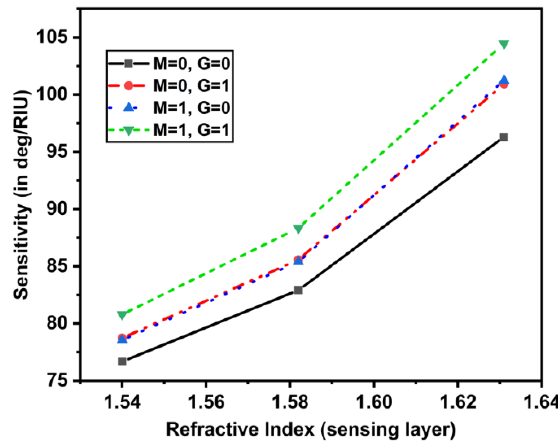
Figure 5. Sensitivity plot w.r.t. the RI of sensing layer (1.54 to 1.64).